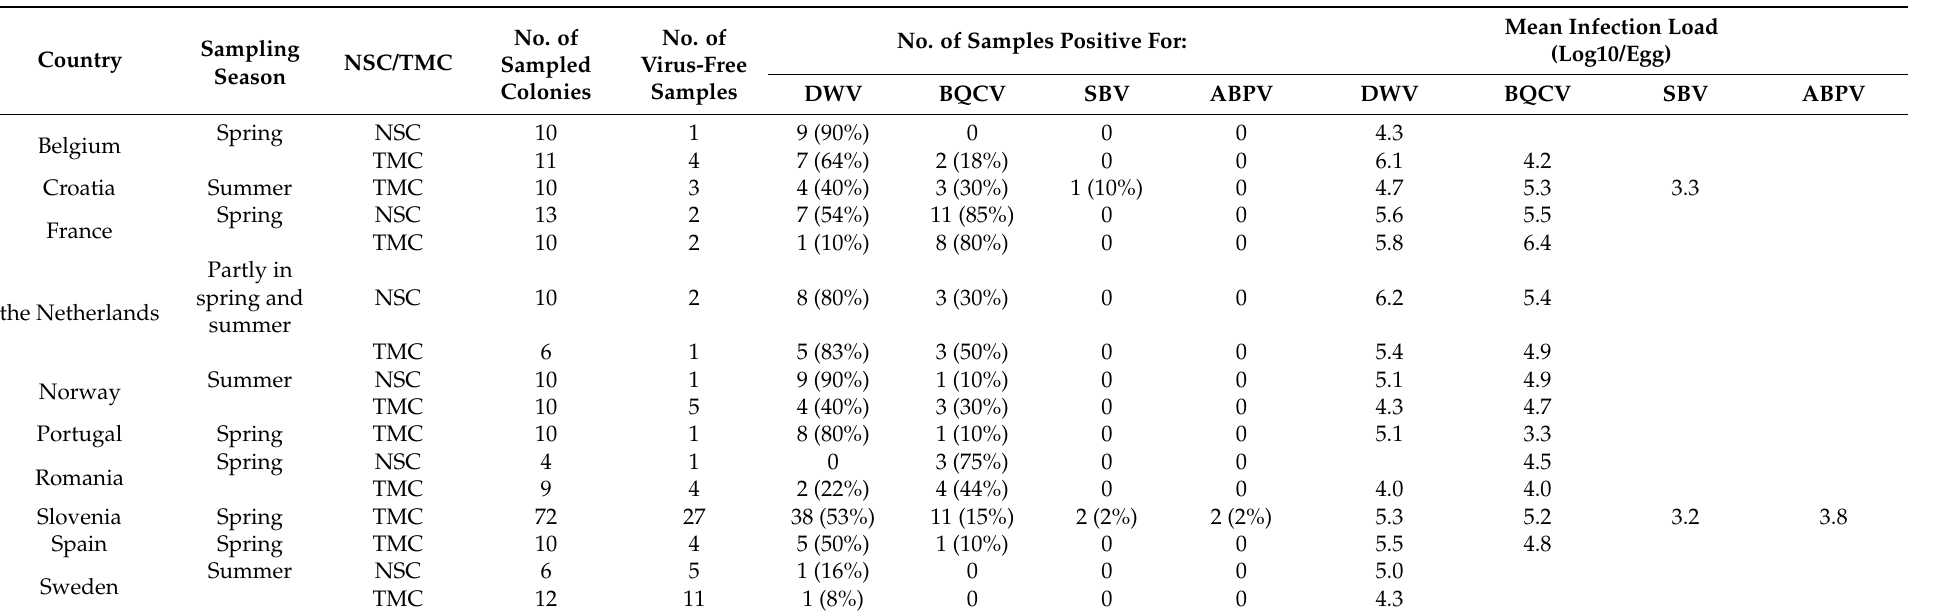
Table 1. Virus prevalence in pooled egg samples from each participating country for both naturally surviving colonies (NSCs) and traditionally managed colonies